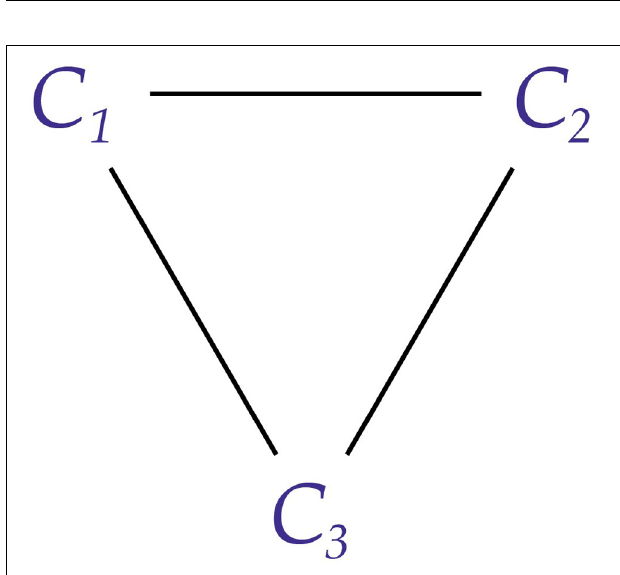
FIGURE 5 | Three adjacent conscious agents. This is a compact representation of the diagram in Figure 4 .